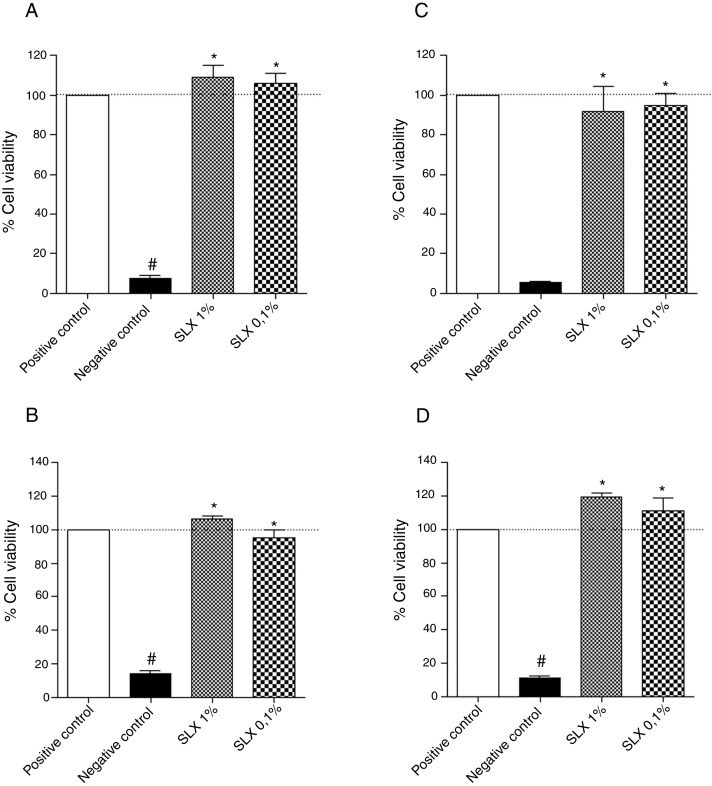
Cell viability. Percentage of viability of NIH-3T3 (undefined) fibroblasts (A–C) and human keratinocytes (B–D) in culture at 24 h (A and B) and 48 h (C and D) relative to the control culture (corresponding to 100% viable cells) by the MTT method, distributed at 1% and 0.1% concentrations of latex serum. Values represent means ± standard error of mean (SEM) of triplicate results. ANOVA statistical test, Bonferroni post-test. *Significant difference (p < 0.05) in relation to the negative control. #Significant difference (p < 0.05) between control groups.